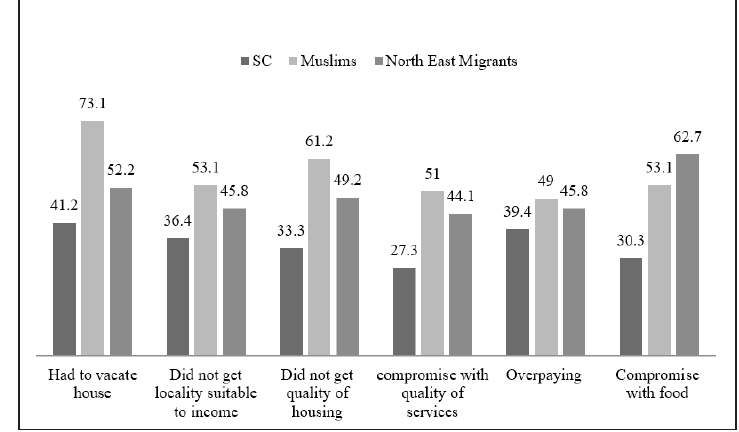
Fig 5. Consequences for Housing and Amenities Source: Primary Field Survey